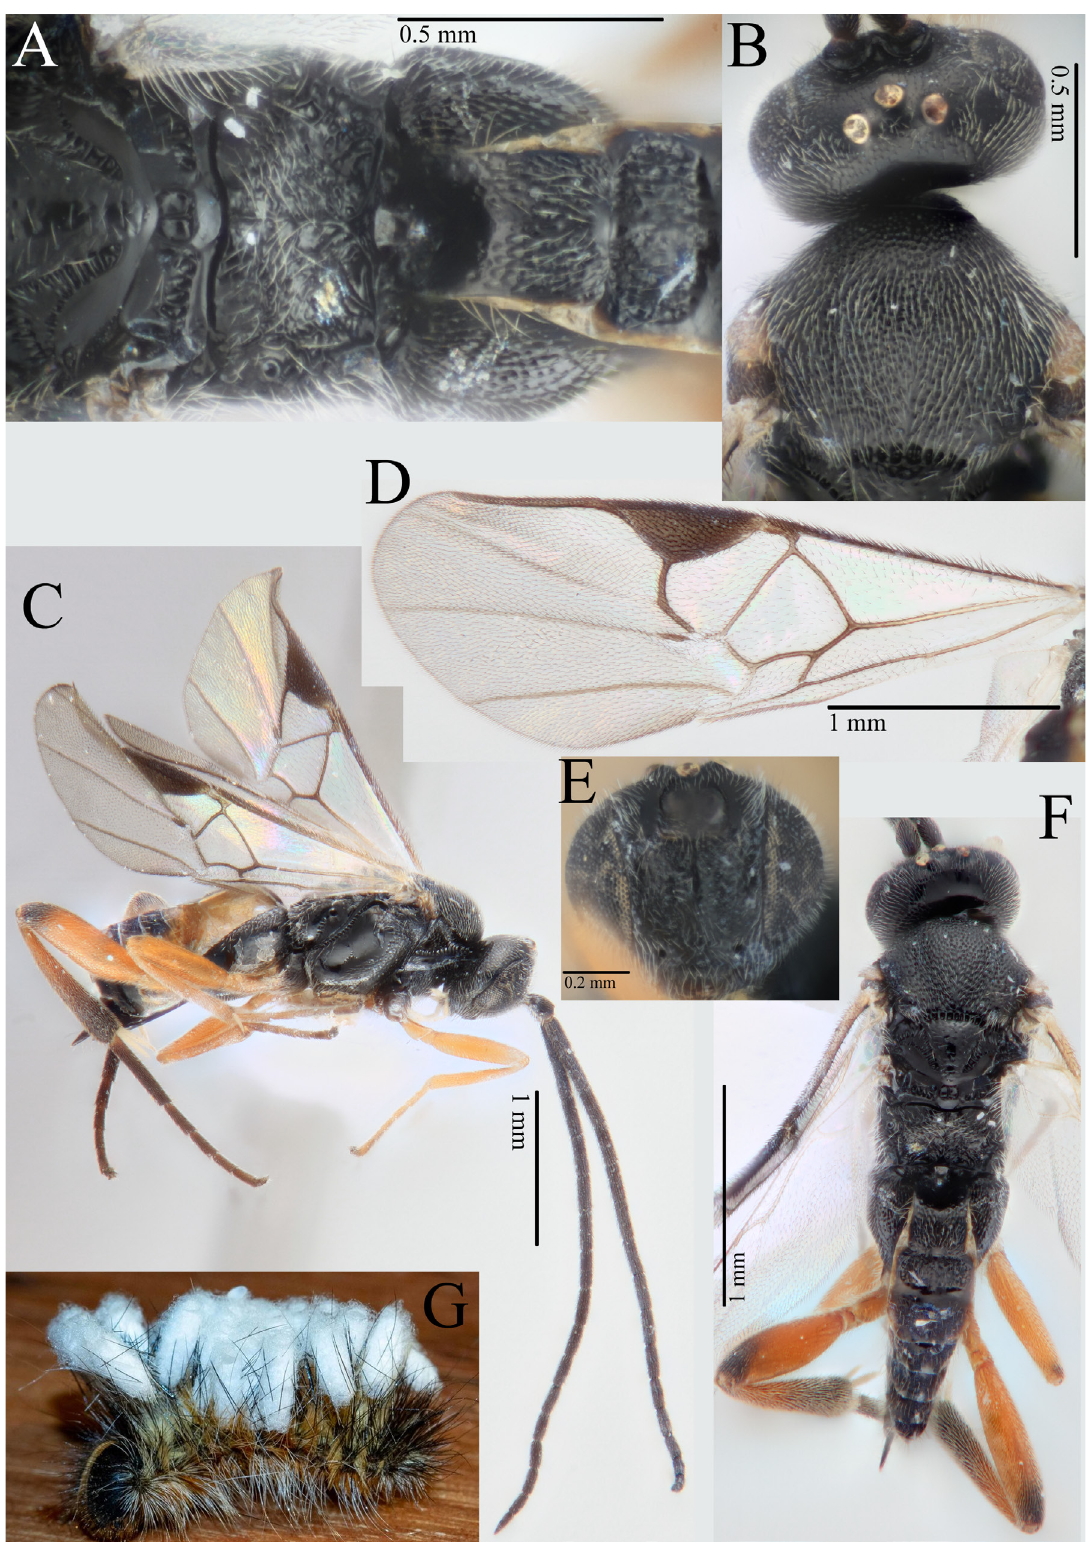
Fig. 32. Cotesia wonboynensis sp. nov., ♀, holotype (ANIC 32 130294) A . Mesoscutellum, propodeum, T1–2. B . Head in dorsal view and anteromesoscutum. C . Habitus in lateral view. D . Fore wing. E . Head in anterior view. F . Habitus in dorsal view. G . Cocoons on host caterpillar (image credit: P.